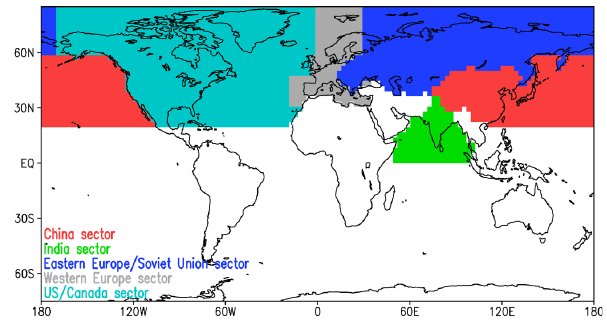
Fig. 8. Division of the world in this